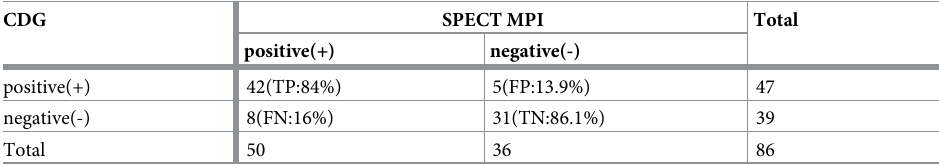
Table 4. Correlation between CDG and SPECT. CDG SPECT MPI Total positive(+) negative(-) positive(+) 42(TP:84%) 5(FP:13.9%) 47 negative(-) 8(FN:16%) 31(TN:86.1%) 39 Total 50 36 86 Accuracy = 84.9%; Sensitivity = 84%; Specificity = 86.1%; Kappa value = 0.693; Positive predictive values (PPV) = 89.4%; Negative predictive values (NPV) = 79.5%; Positive likelihood ratio (LR+) = 6.04; Negative likelihood ratio (LR-) = 0.186.